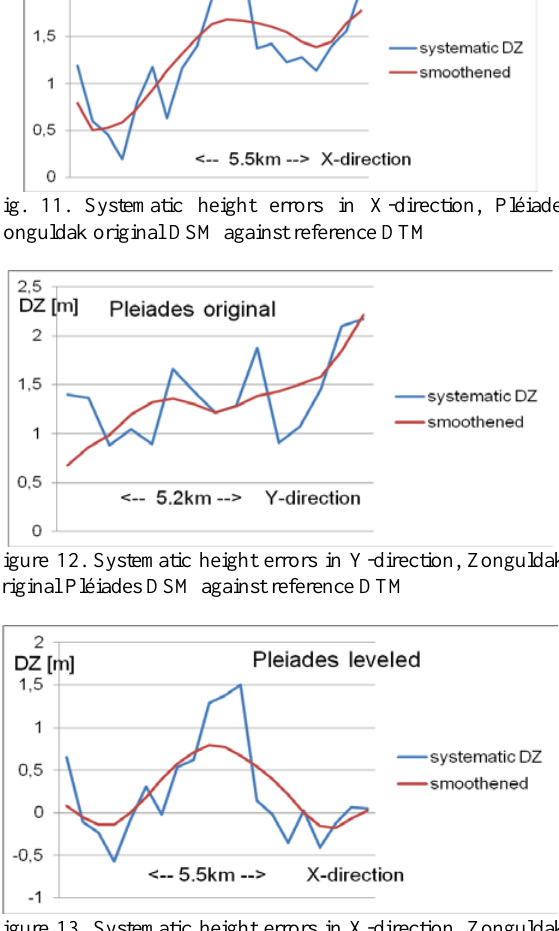
Figure 13. Systematic height errors in X-direction, Zonguldak, leveled Pléiades DSM against reference